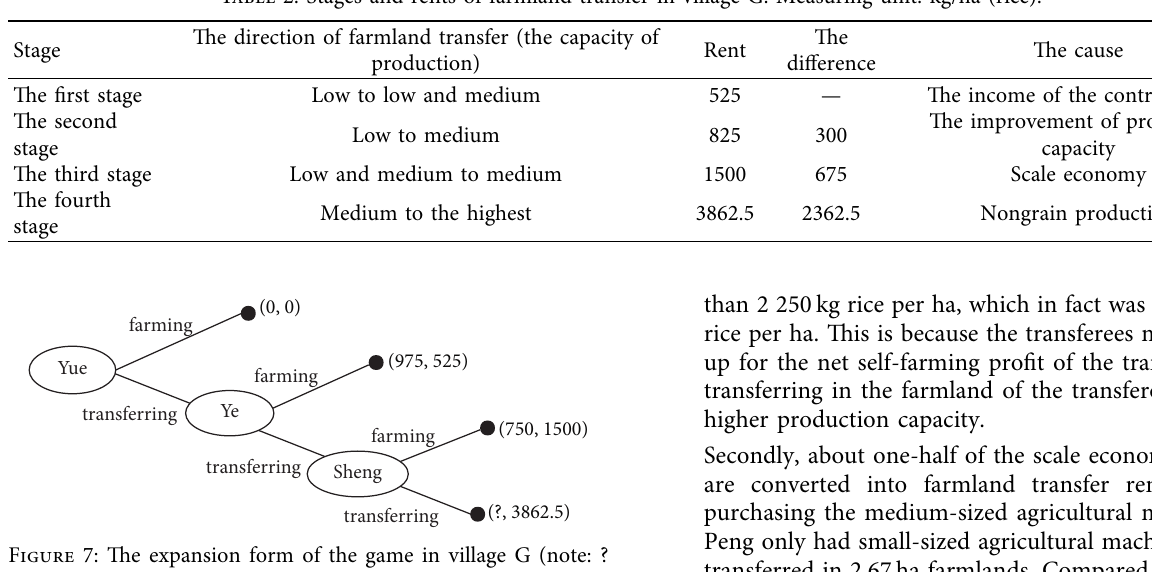
Table 2: Stages and rents of farmland transfer in village G. Measuring unit: kg/ha (rice).